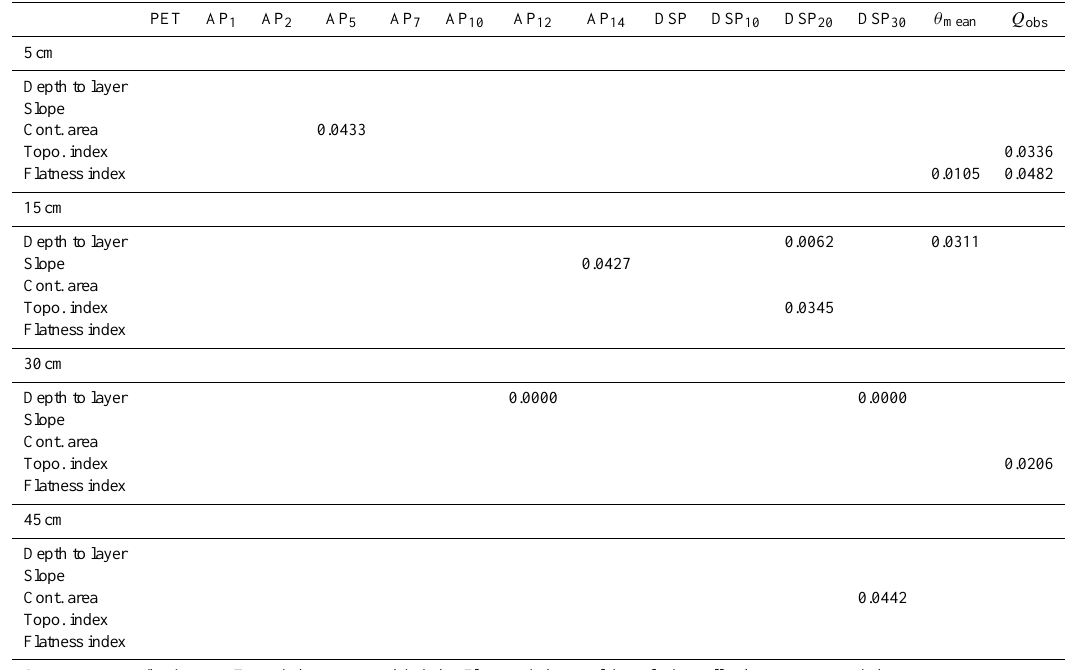
Table 5. Influence of the soil confining layer topography (rows) on the nature of the point-scale relationships between soil moisture content and various surrogates (columns). Reported p-values are significant and suggest that at least one relationship type is associated with a median value of the studied topographic variable that is significantly different from the